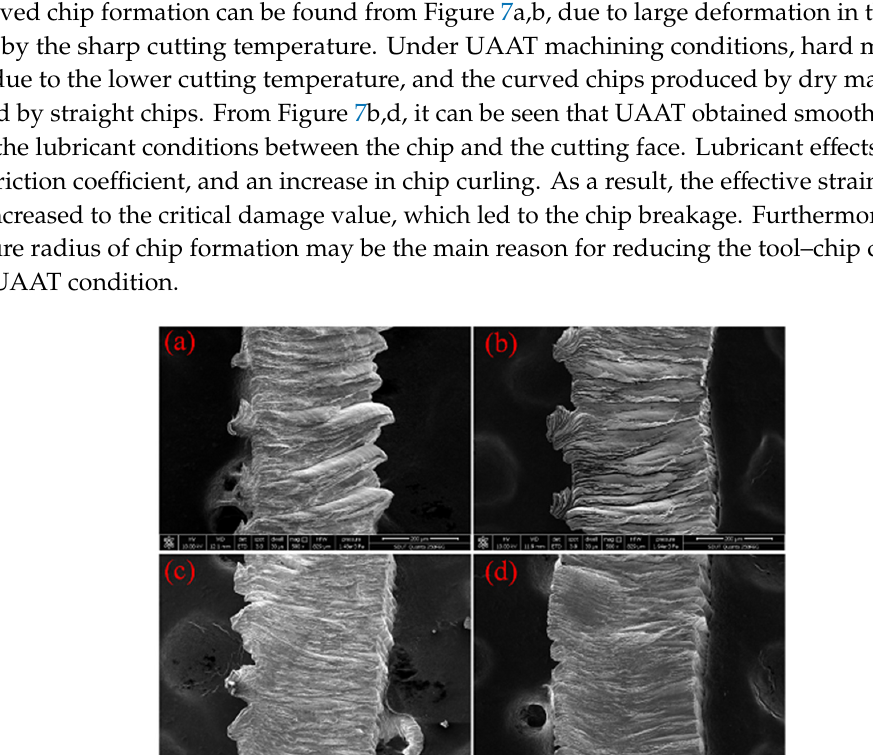
Figure 7. Chip morphology under ( a , b ) dry machining, and ( c , d ) ultrasonic atomization assisted machining at cutting speeds of ( a , c ) 20 m/min, and ( b , d ) 60 m/min.